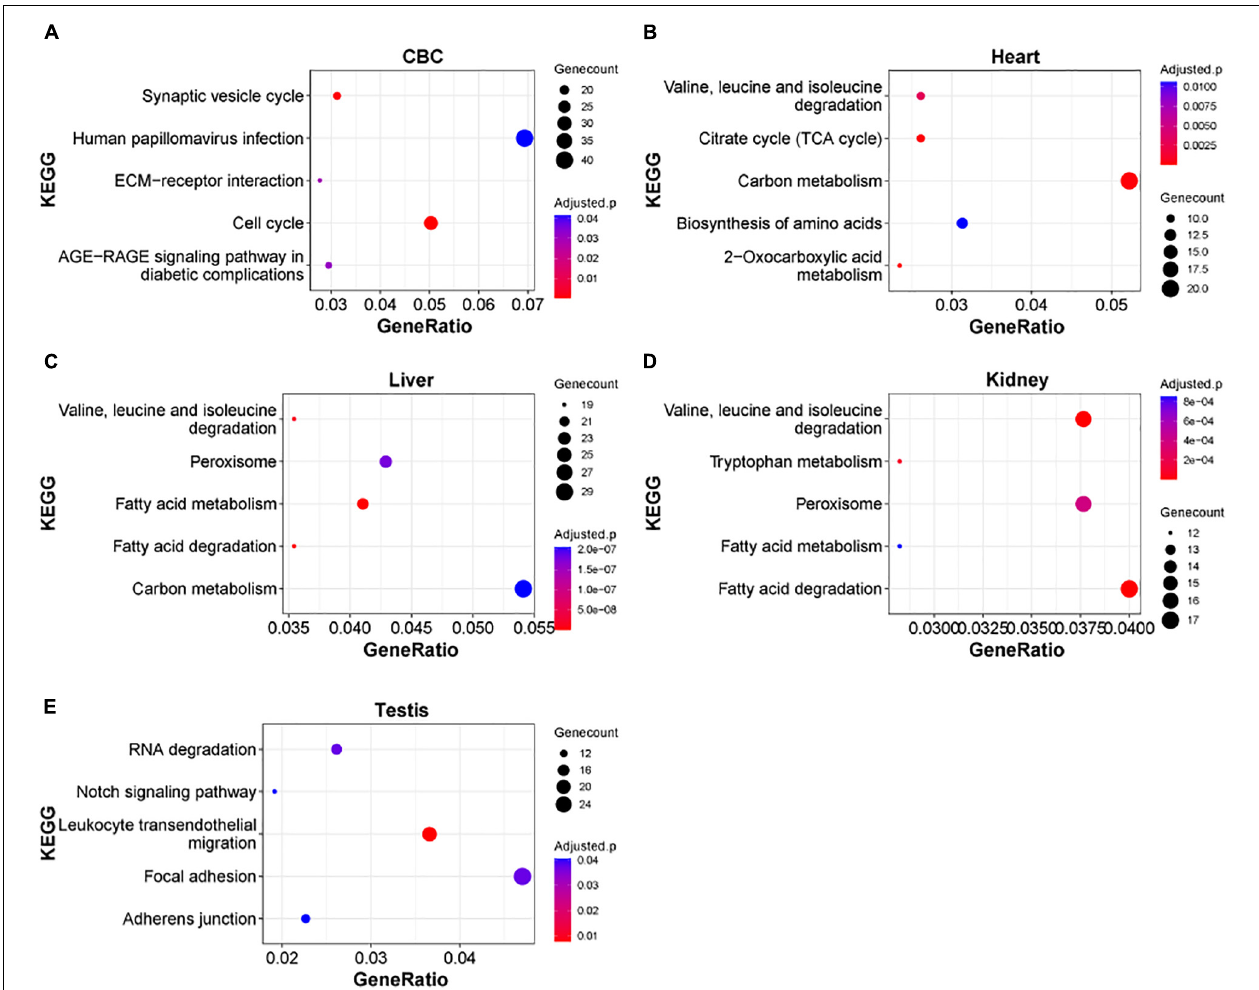
FIGURE 4 | KEGG pathways of DEGs in rhesus macaque organs. (A–E) Represent top enriched functional categories in the developmental DEGs of cerebellum (CBC), heart, liver, kidney, and testis. Pathway terms were sorted from smallest to largest by p -value. Smaller p -values are indicated by darker red color. The size of the circle represents the number DEGs enriched and the x -axis represents the odd